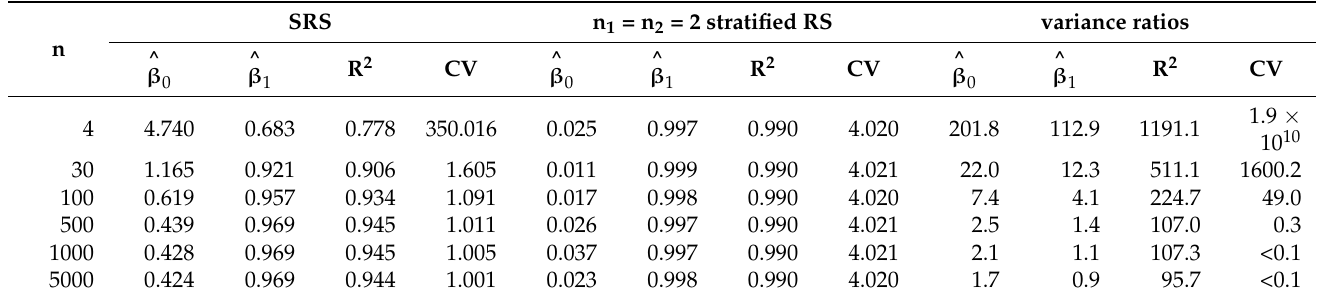
Table 3. Varying n SRS versus fixed small n stratified RS; population: β 0 = 0, β 1 = 1, R 2 = 1, and CV = 1; 10,000